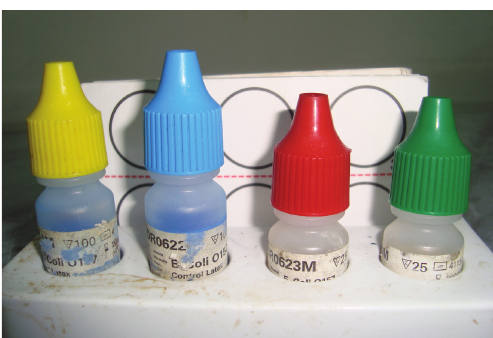
Figure 3: Agglutination kit (Oxoid) for diagnosis of E. coli